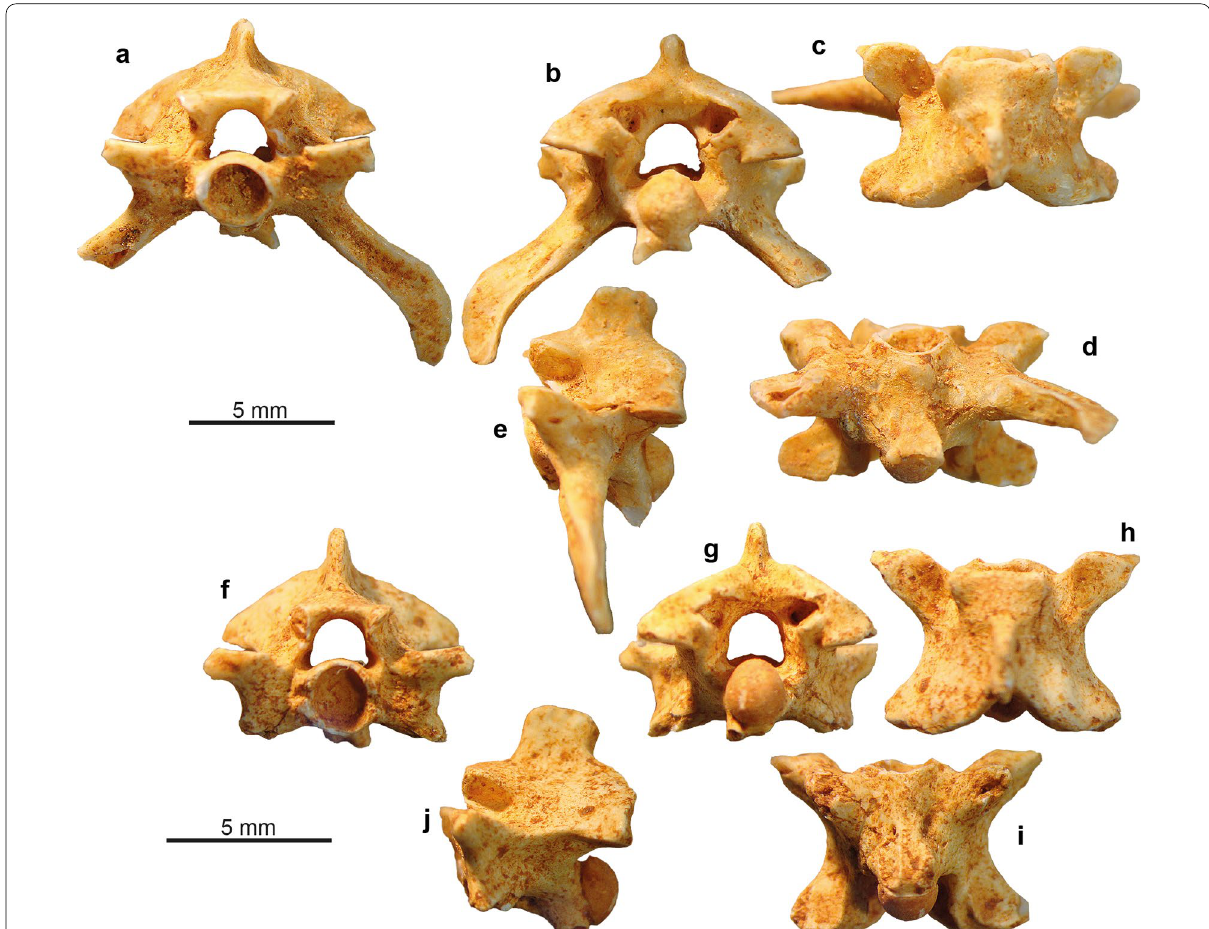
Fig. 95 Phosphoroboa filholii comb. nov. from the late Eocene of Escamps C, Phosphorites du Quercy: a – e anterior-most caudal vertebra (UM ECC 3097) in anterior ( a ), posterior ( b ), dorsal ( c ), ventral ( d ), and left lateral ( e ) views; f – j mid-caudal vertebra (UM ECC 3098) in anterior ( f ), posterior ( g ), dorsal ( h ), ventral ( i ), and left lateral ( j )